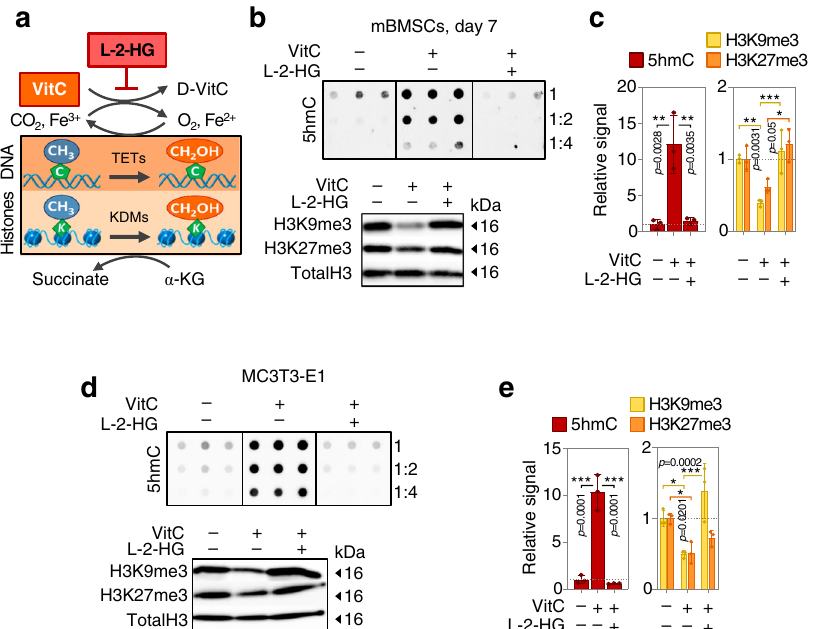
Fig.6|VitaminCcontrolstheactivityofepigenetic α KGDDsduringosteogenic differentiation.a InhibitionofVitCdependent α -ketoglutaratedehydrogenasesby L-2-hydroxyglutarate (L-2-HG) during osteogenic differentiation. b Inhibition of VitCdependent5hmCsynthesisandH3K9me3aswellasH3K27me3demethylation byL-2-HGduringosteogenicdifferentiationofprimarymBMSCsandquanti fi cation ofblots( c ). d EffectsofL-2-HGindifferentiatingcalvarialMC3T3-E1pre-osteoblasts on 5hmC deposition and H3K9me3 as well as H3K27me3 demethylation and